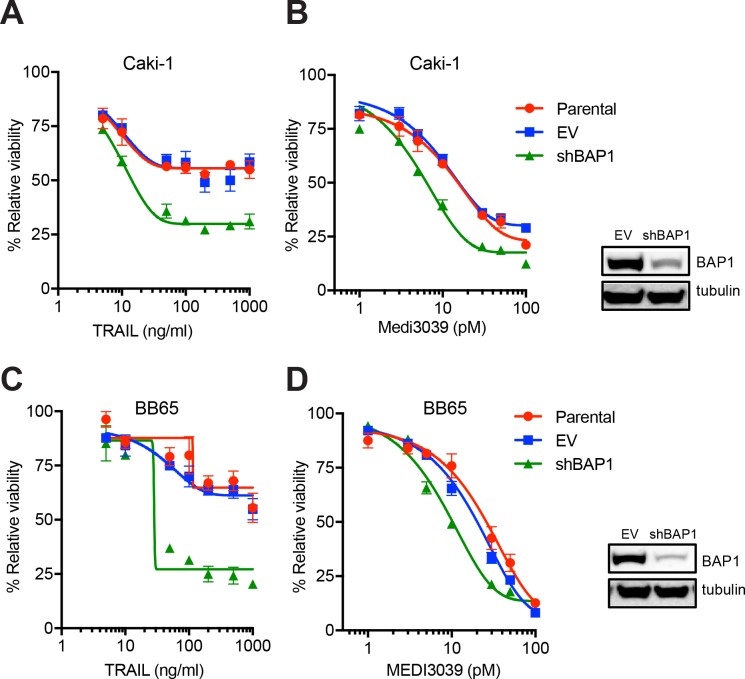
shRNA knockdown of BAP1 increases sensitivity to DR agonists in clear cell renal carcinoma cells. Clear cell renal carcinoma cell lines, Caki-1 and BB65, were transduced either with either empty vector (EV) or BAP1 shRNA (shBAP1). Immunoblot confirmed BAP1 knockdown. Cells were treated with rTRAIL (A and C) or MEDI3039 (B and D) for 72 hr and cell viability measured by MTT assay.